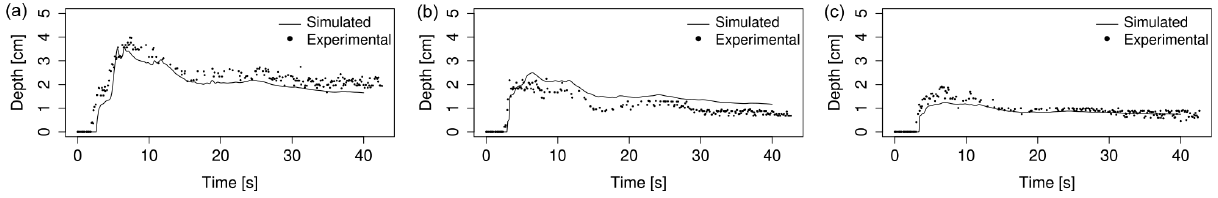
Figure 10. Simulated and experimental transient water depths at three gauge points ( a x = 2.25m, y = 0m; b x = 2.40m, y = 0.08m; c x = 2.60m, y = 0m) for the G3 flume dam break over several